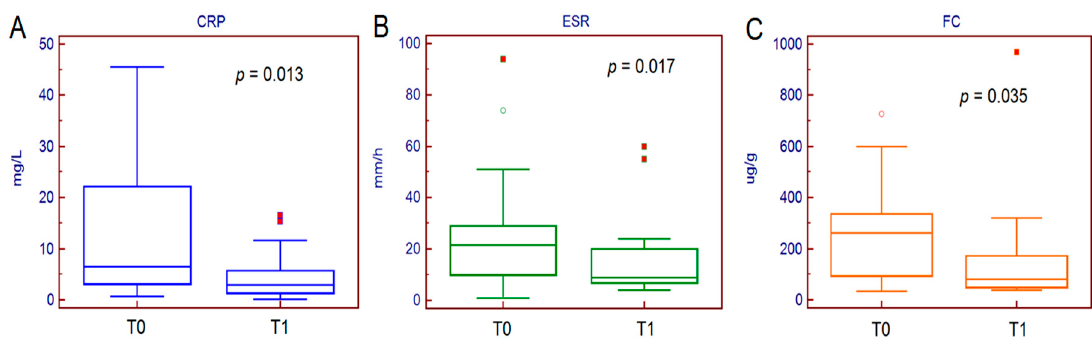
Figure 1. Serum and faecal inflammatory biomarkers trend after six months of adalimumab therapy.